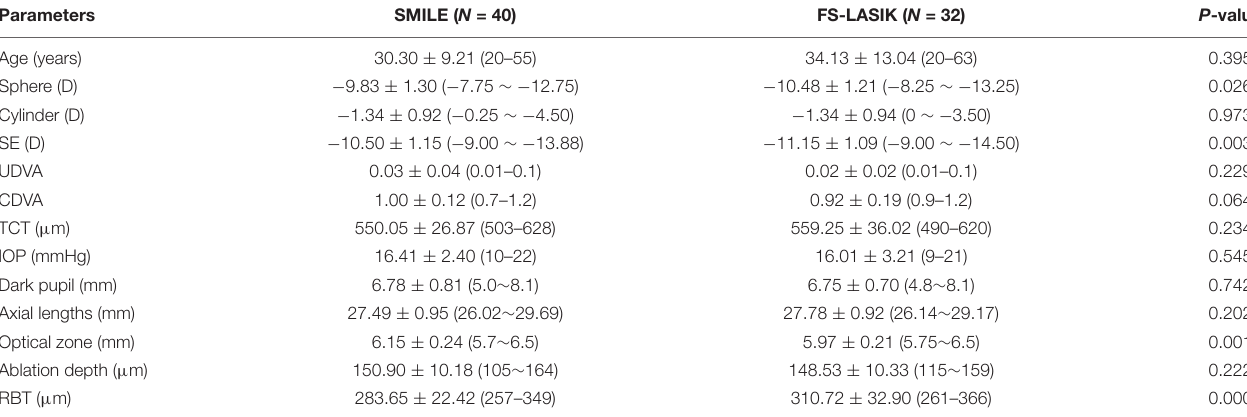
TABLE 1 | Baseline and surgical information of small incision lenticule extraction (SMILE) and femtosecond laser-assisted in situ keratomileusis (FS-LASIK).